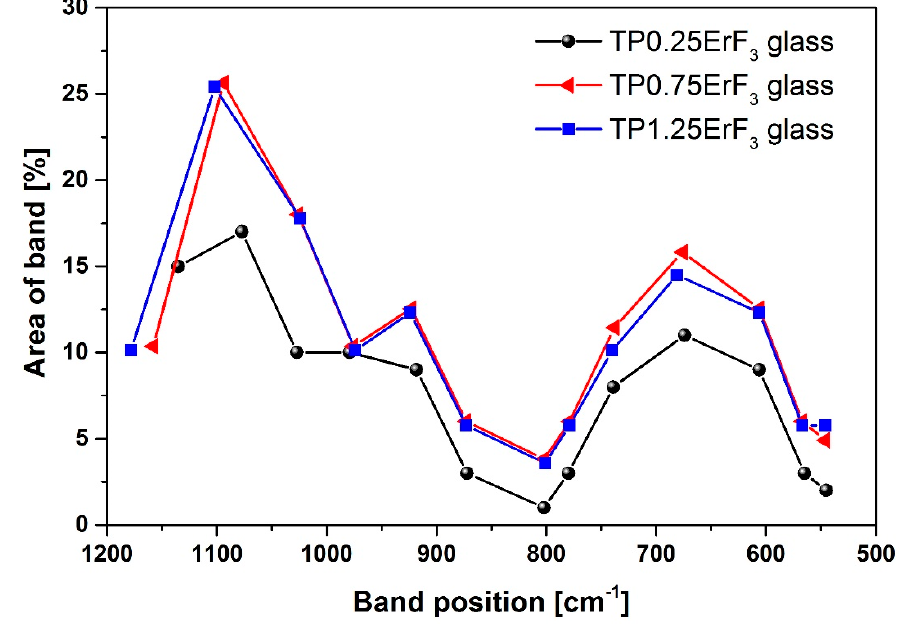
Figure 6. Deconvoluted FTIR spectra of TP1.25ErF 3 glass. (inset) Deconvoluted and experimental spectra. Figure6. DeconvolutedFTIRspectraofTP1.25ErF 3 glass. (inset)Deconvolutedandexperimentalspectra.